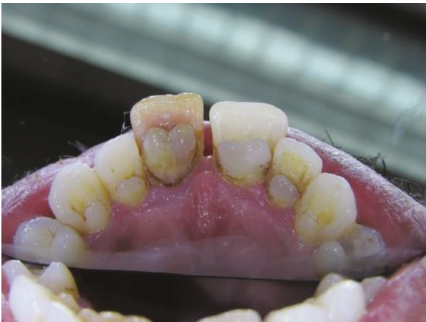
Figure 1: Case 1: heart-shape tubercles on both central incisors and typical talon-shape tubercles on both laterals and canines.